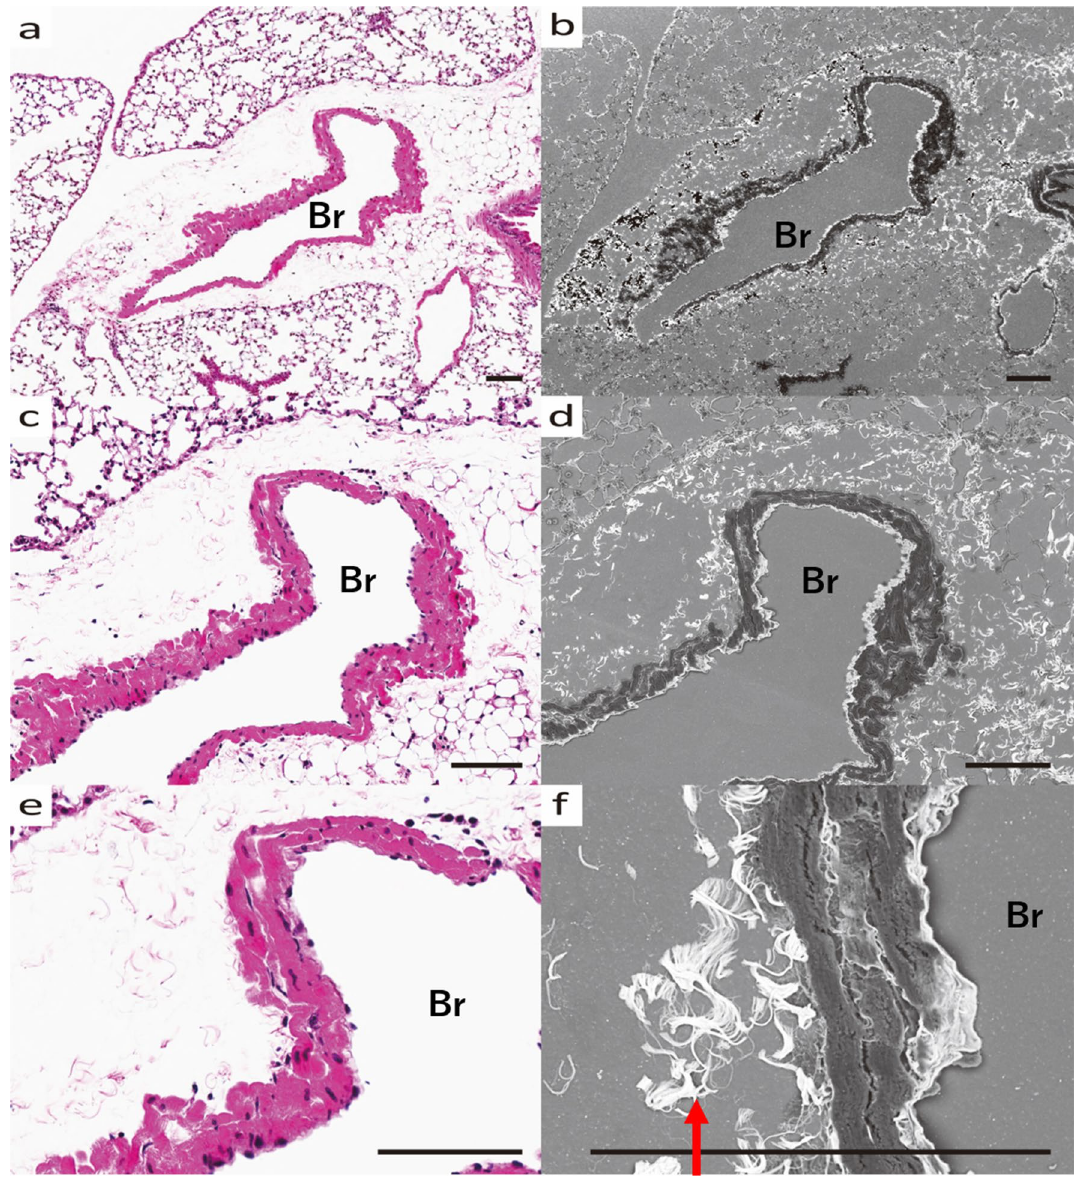
Figure 6. Bronchi (Br) and surrounding stroma of AregKO mice (HDM-sensitized). ( a ) Optical microscope image (HE stained) and ( b ) SEM image (Grocott stained) of pulmonary tissue. ( c ) Optical microscope image (HE stained) and ( d ) SEM image (Grocott stained) of Br. ( e ) Optical microscope image (HE stained) and ( f ) SEM image (Grocott stained) of enlarged Br and interstitium. ( a – d ) Edematous changes around the bronchi are seen. ( e , f ) Amorphous substrate of the interstitium (arrow) is stained without fibrous tissue. All scale bars show 100 μm